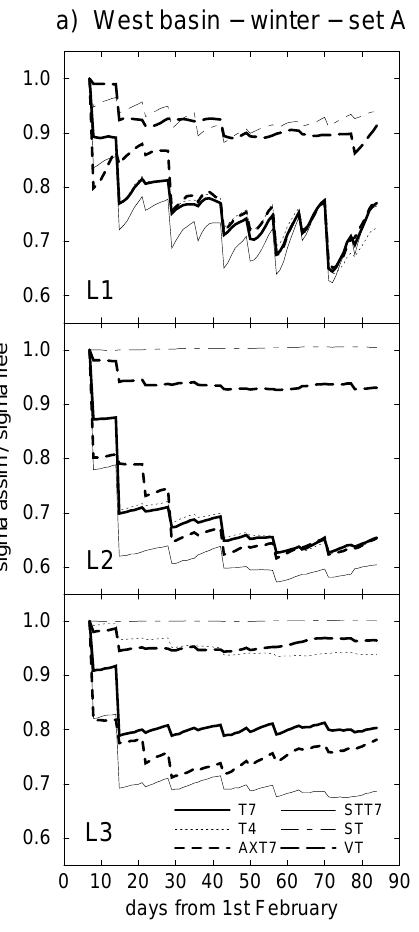
Fig. 7. As Fig. 5 for winter OSSEs.